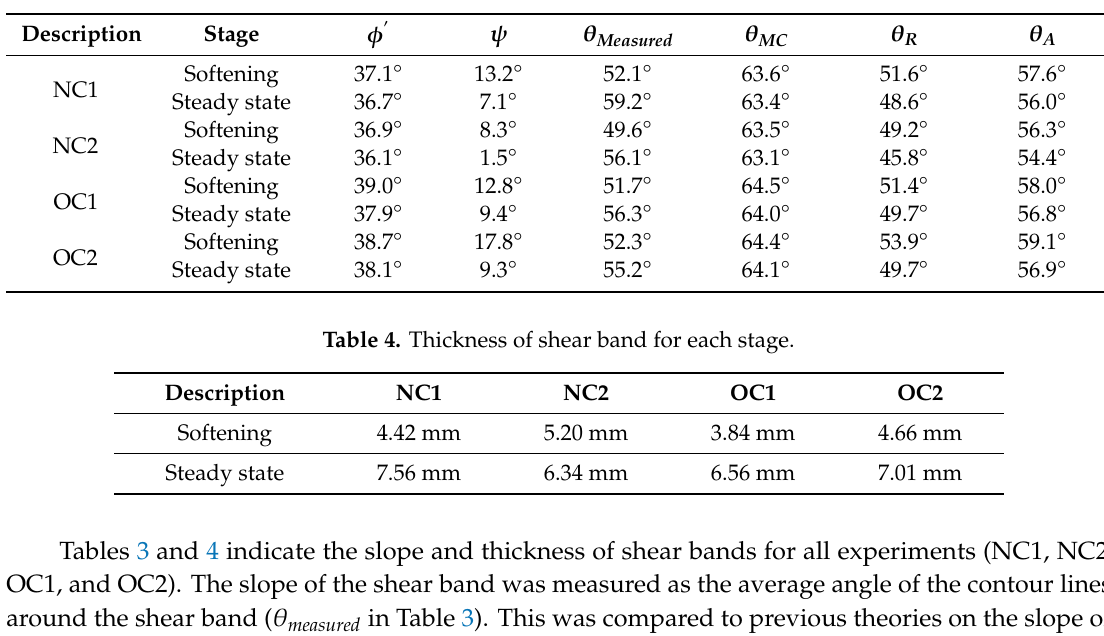
Figure 13. Increasing shear strain for OC1: ( a ) initial; ( b ) peak; ( c ) softening; and ( d ) steady state. Table 3. Inclination angles for each stage with the internal friction and dilatation angle.